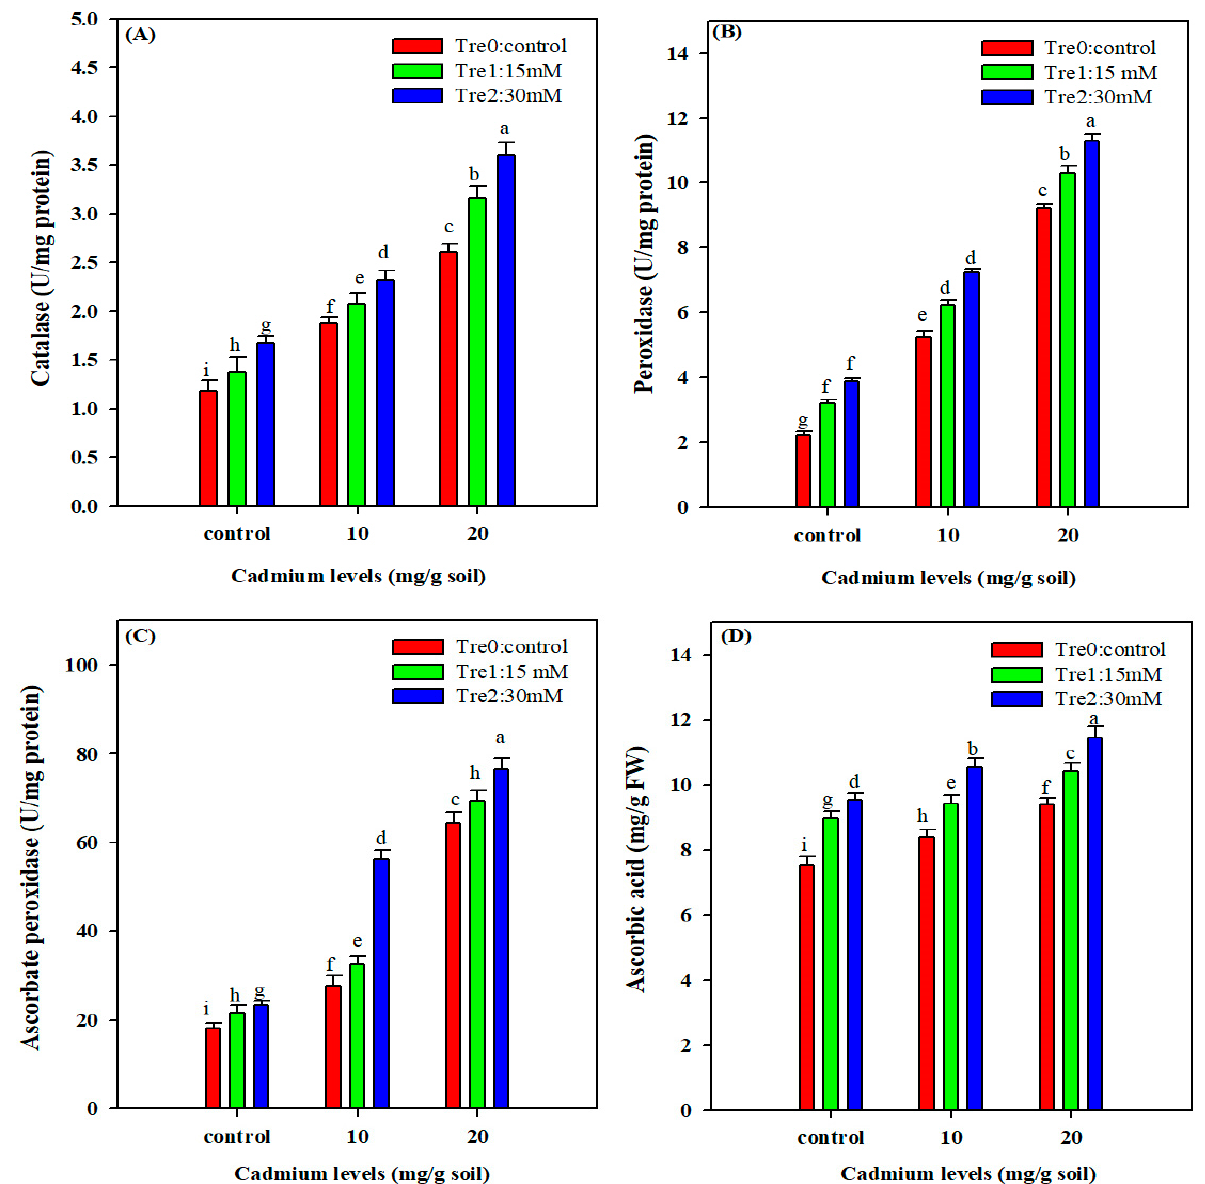
Figure 4. Effect of foliar spray of Tre on activities of CAT ( A ), POD ( B ), APX ( C ) and AsA ( D ) in mung bean plants grown under Cd stress. The values given in vertical bars are showing the mean of three replicates with ± S.E and the different letters above the bars under the same treatment show the significant differences at p < 0.05.